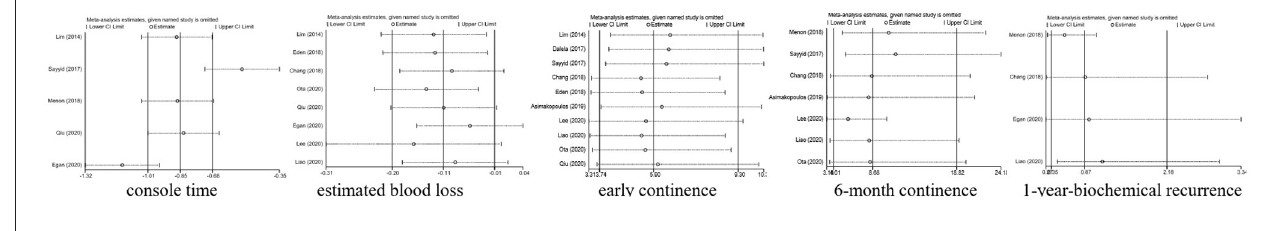
FIGURE 11 | Sensitivity analysis.